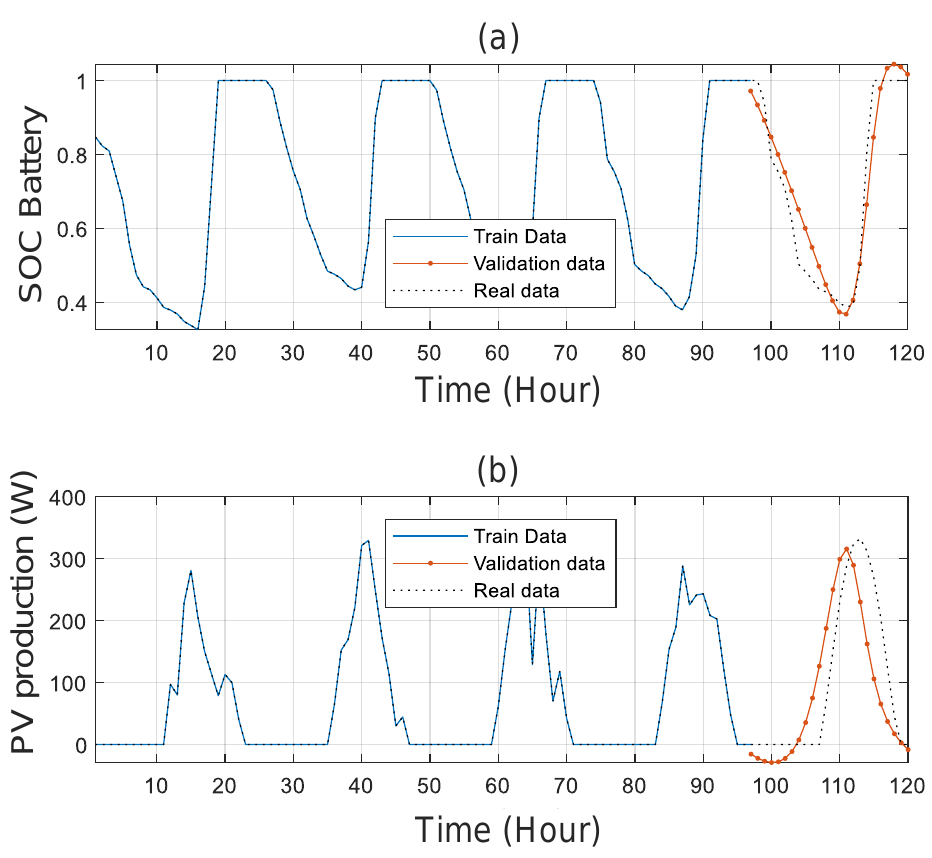
Figure 8. ( a ) Hourly state of charge. ( b ) Hourly production of the PV panels.